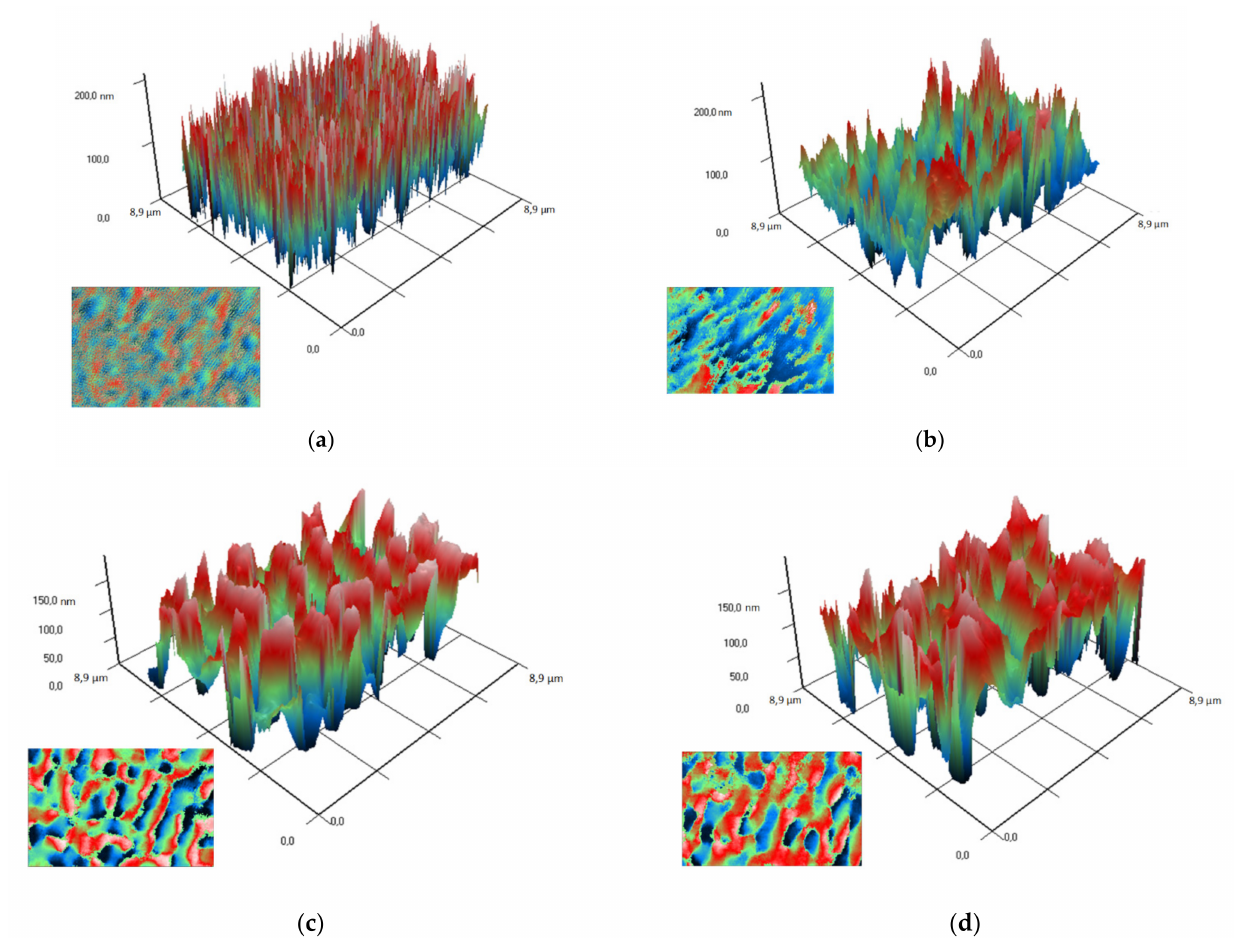
Figure 4. Images obtained on polymer without nanoparticles ( a ) and polymers with ZnO nanopar- ticles at a concentration of 0.001% ( b ), 0.01% ( c ) and 0.1% ( d ) using a modulation interference microscope. A 3D reconstruction of the surface profile of a polymer and composites based on it is presented. The X and Y axes show the actual size of the investigated surface in micrometers. The Z-axis shows the surface relief as a phase change expressed in nm. In the lower left corner of each figure is a top view (surface elevation map).